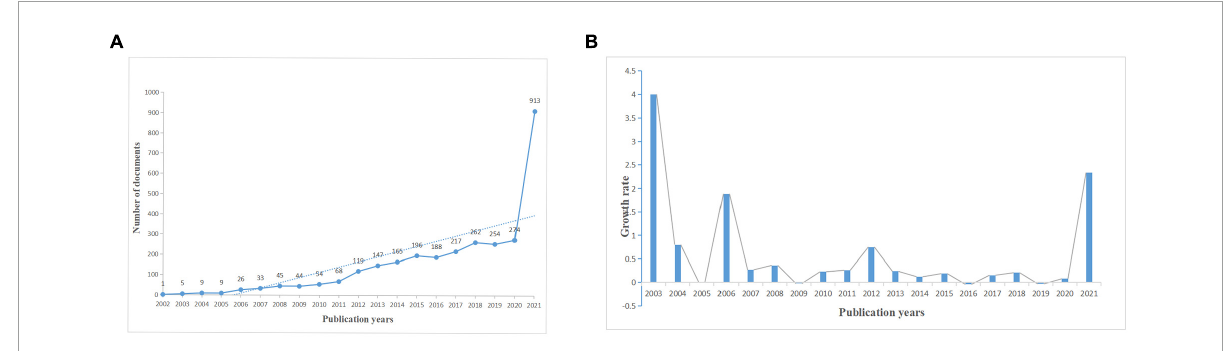
FIGURE3 Distribution of publications by year. (A) The distribution of publications according to year. (B) The growth rate of publications according to